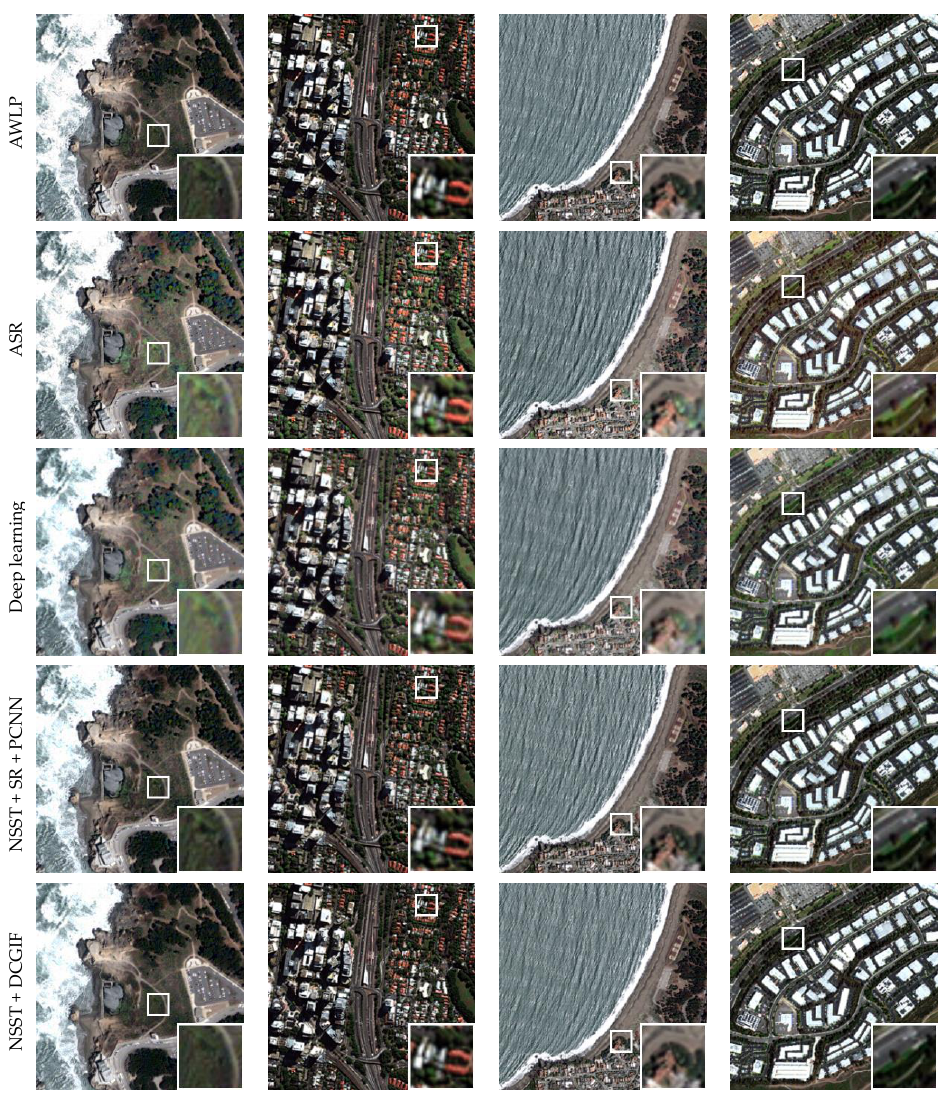
Figure 14. MS and Degraded data comparison experiment results.